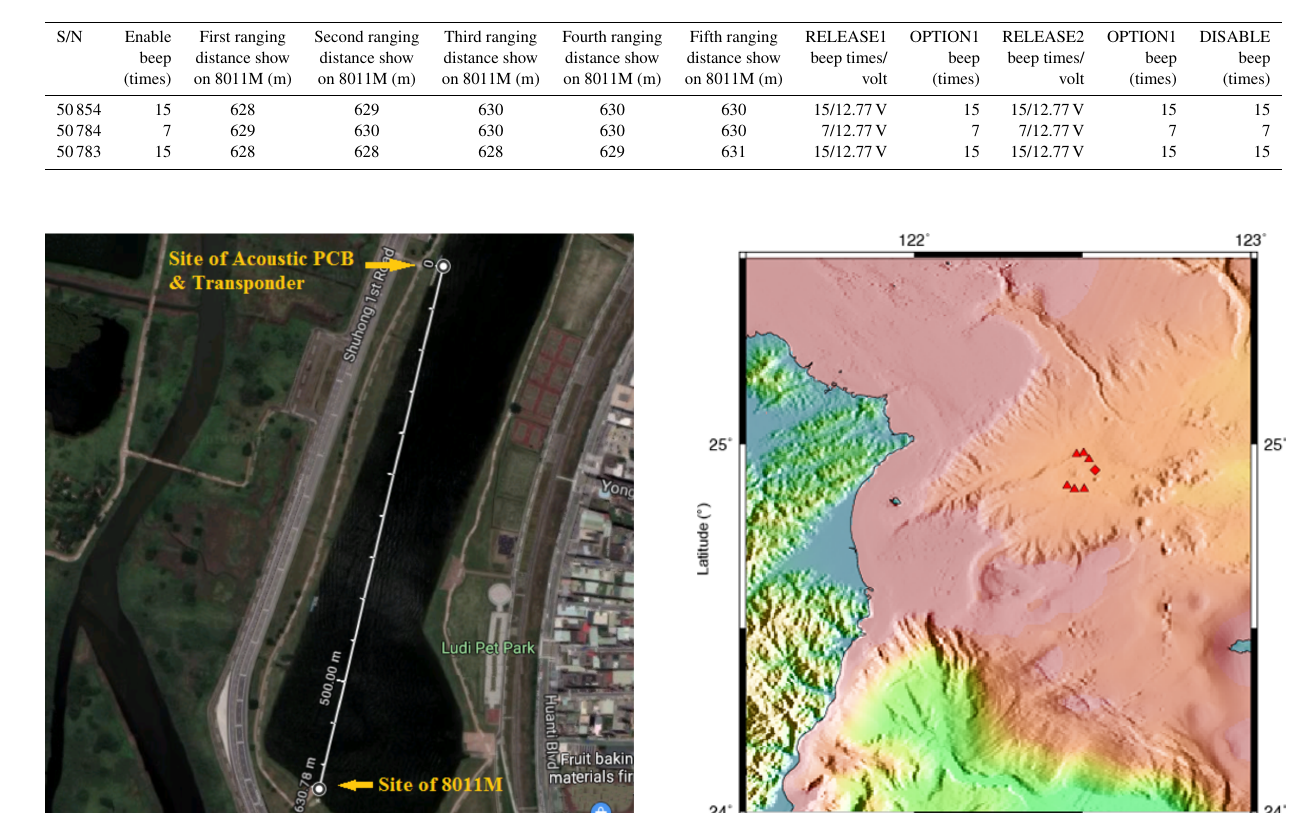
Table 5. Example results for the functional test of the acoustic controller.